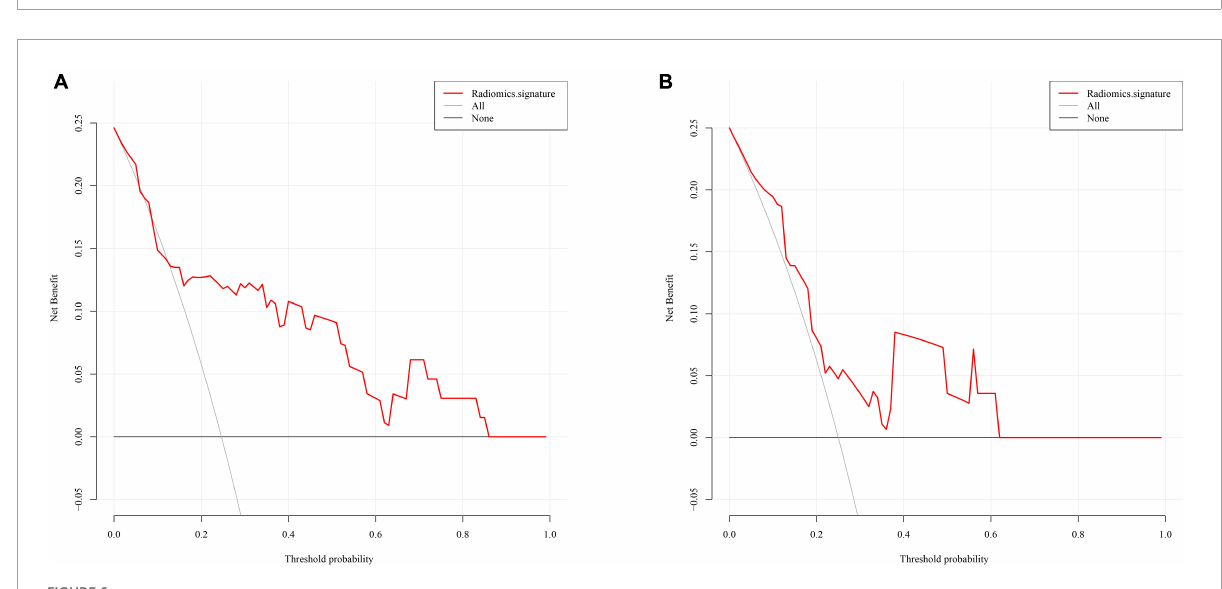
FIGURE6 Decision curve analysis for the radiomics signature in the training/validation cohort (A) and testing cohort (B) .